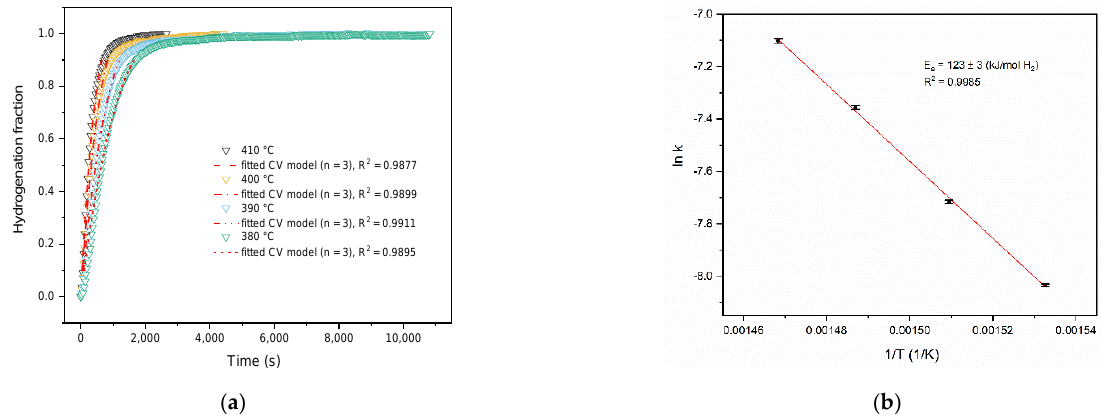
Figure 7. ( a ) The hydrogenation kinetic curves of the Li-RHC + AlTi 3 sample at different temperatures fitted with CV ( n = 3) model; and ( b ) calculated hydrogenation activation energy of the Li-RHC + AlTi 3 sample.